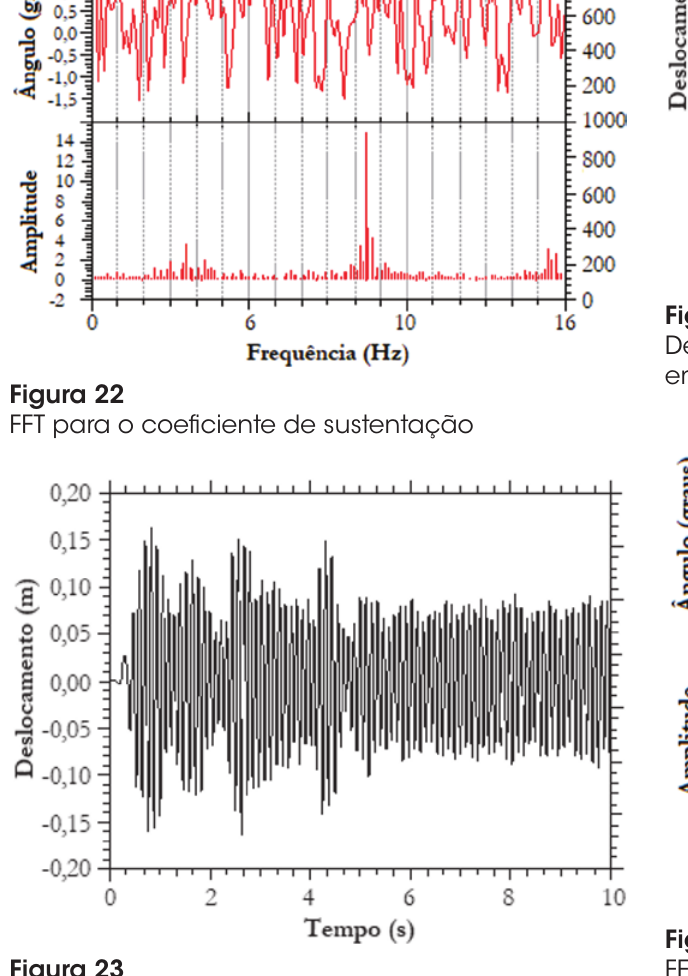
Deslocamento do Vértice superior esquerdo x Tempo